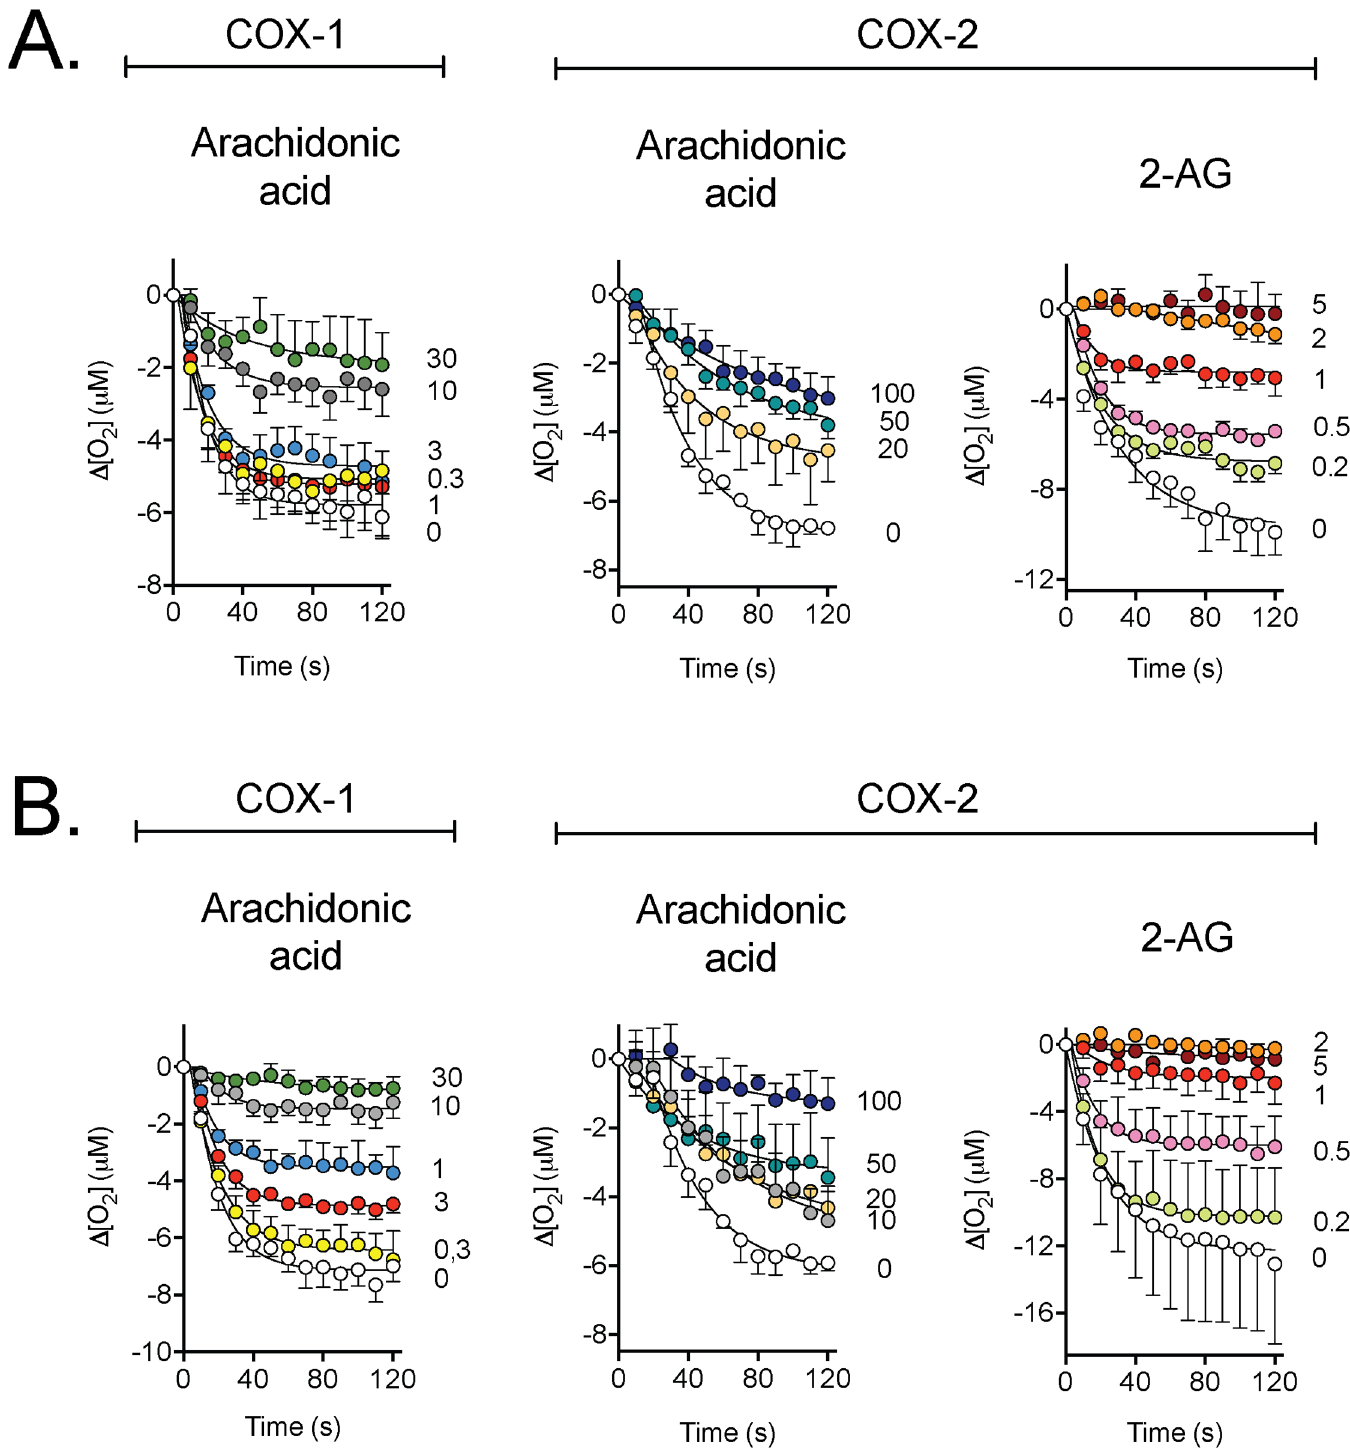
Fig 1. Inhibition of COX isoforms by the enantiomers of Flu-AM1. Shown are means ± s.e.m., n = 3 for the change in oxygen tension following addition of enzyme in the presence of the concentrations of Panel A, ( R )-Flu-AM1 and Panel B, ( S )-Flu-AM1. The concentrations, in μ M, of the inhibitors are shown on the right of each panel, and the enzyme isoform and substrate (10 μ M concentration) used above each panel.